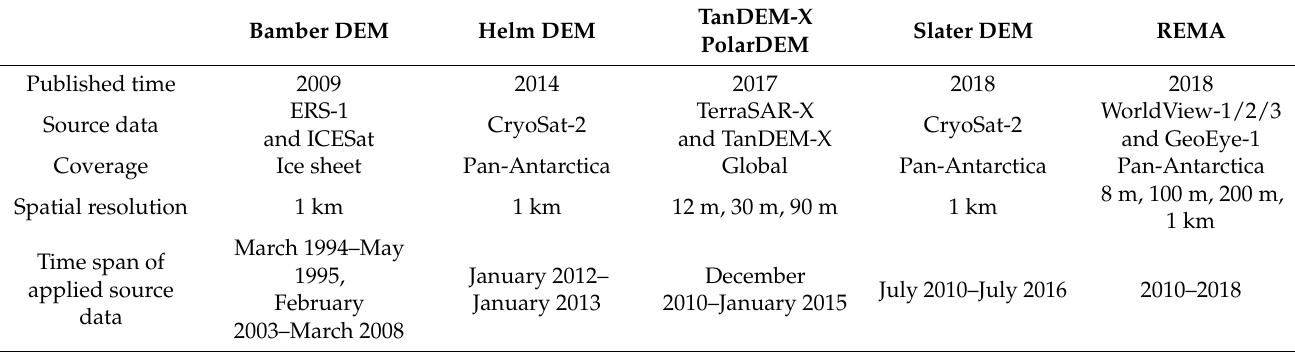
Table 1. General information of five previously published Antarctic digital elevation models (DEMs). Bamber DEM Helm